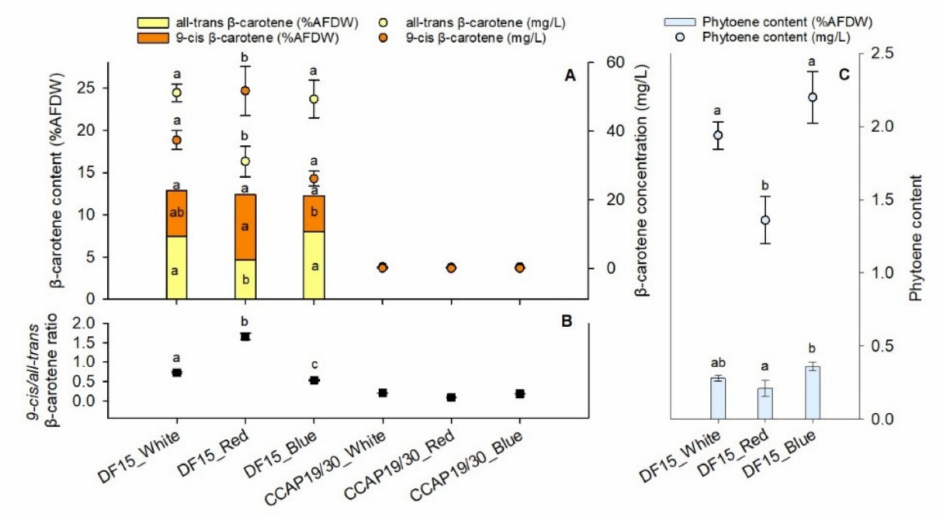
Figure 4. The 9-cis and all-trans β -carotene contents ( A ), 9-cis / all-trans β -carotene ratio ( B ) and phytoene content ( C ) of D. salina DF15 and D. salina CCAP19/30 at the end of the experiment. Cultivation was conducted at 25 ◦ C, pH 7.5 and 100 rpm mixing using white, red and blue light at 200 µ mol photons m − 2 s − 1 . Data are expressed as the means ± standard deviation. Different letters indicate statistically different groups for D. salina DF15 (significance level at p -value <